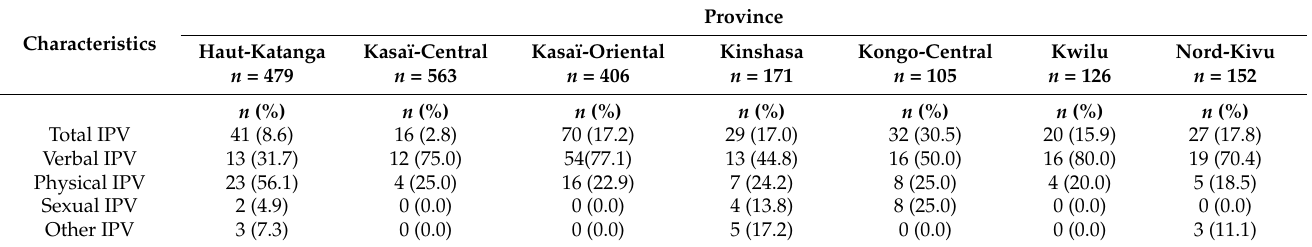
Table 3. Type of Intimate Partners’ Violence reported by women, by province.